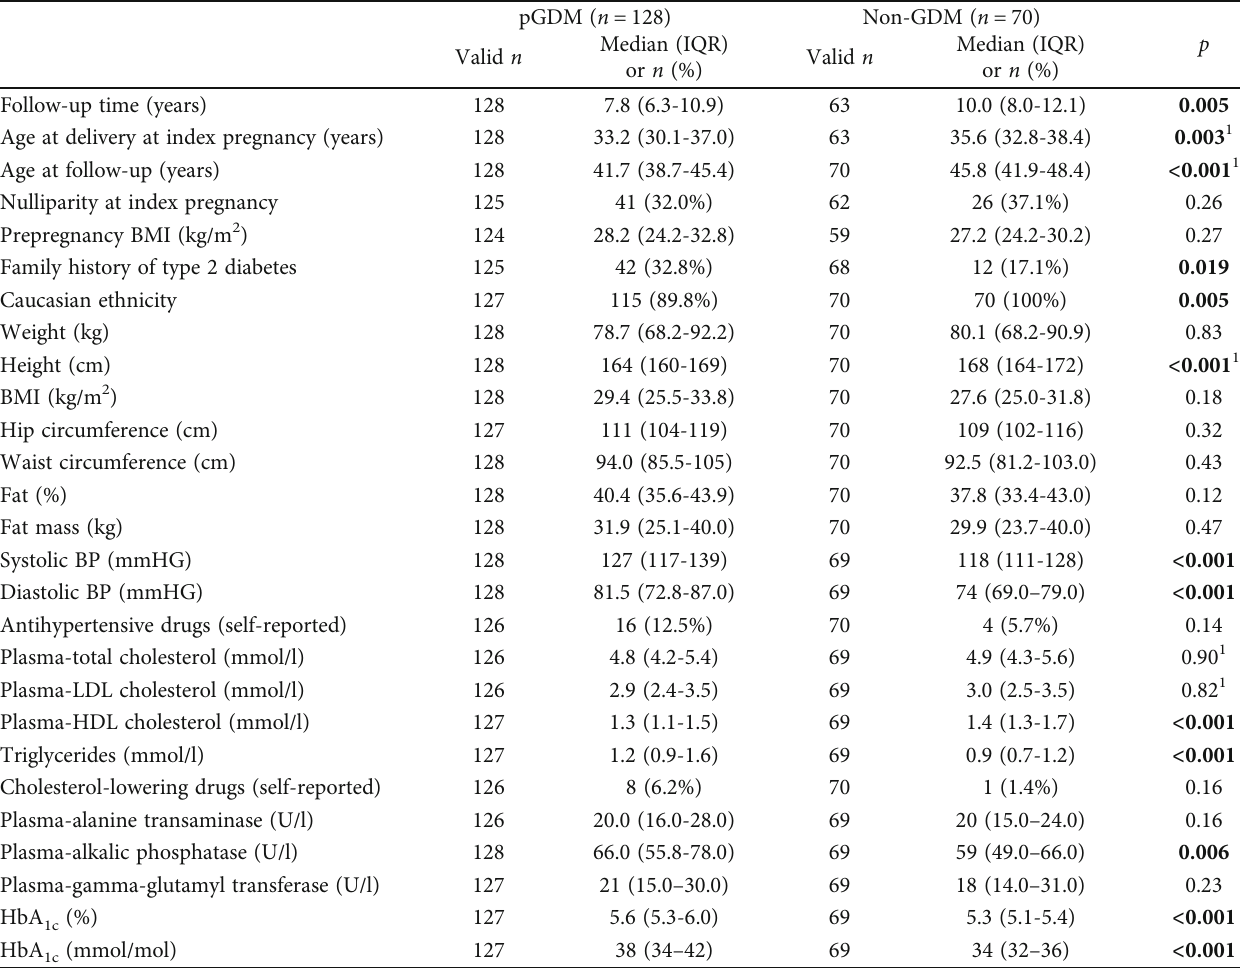
Table 1: Comparison of clinical and metabolic characteristics between women with previous gestational diabetes mellitus (pGDM) and controls